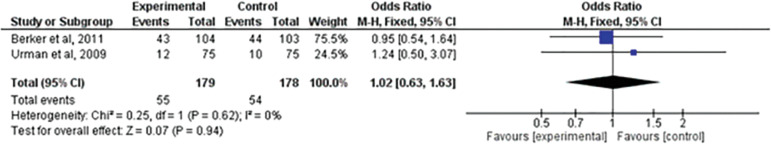
Forest-plot of multiple pregnancies incidence with treatment